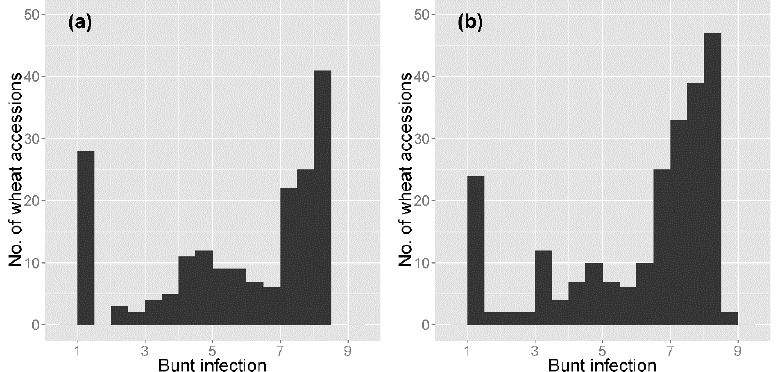
Figure 1. Histograms showing common bunt incidence in a collection of 248 wheat accessions. ( a ) in the year 2011; ( b ) averaged over 2011 and 2012.